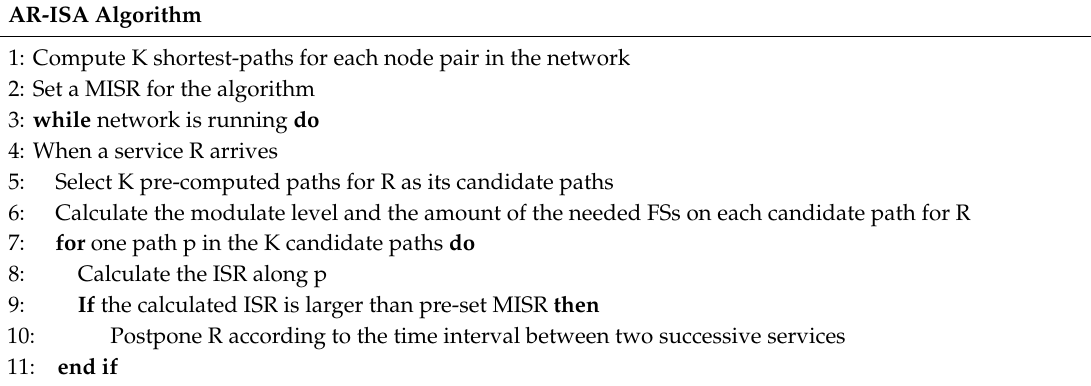
Algorithm 1. Details of the proposed AR-ISA